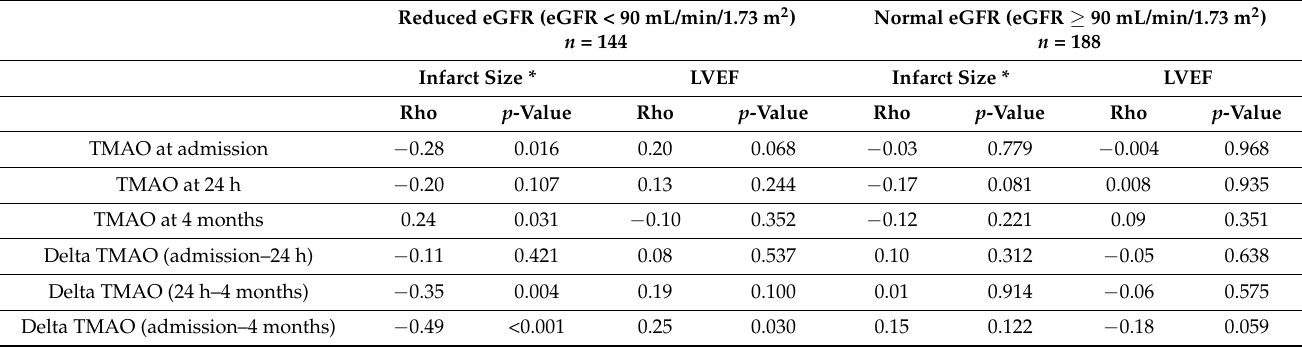
Table 3. Spearman correlations between TMAO and MRI indices 4 months post-STEMI stratified by